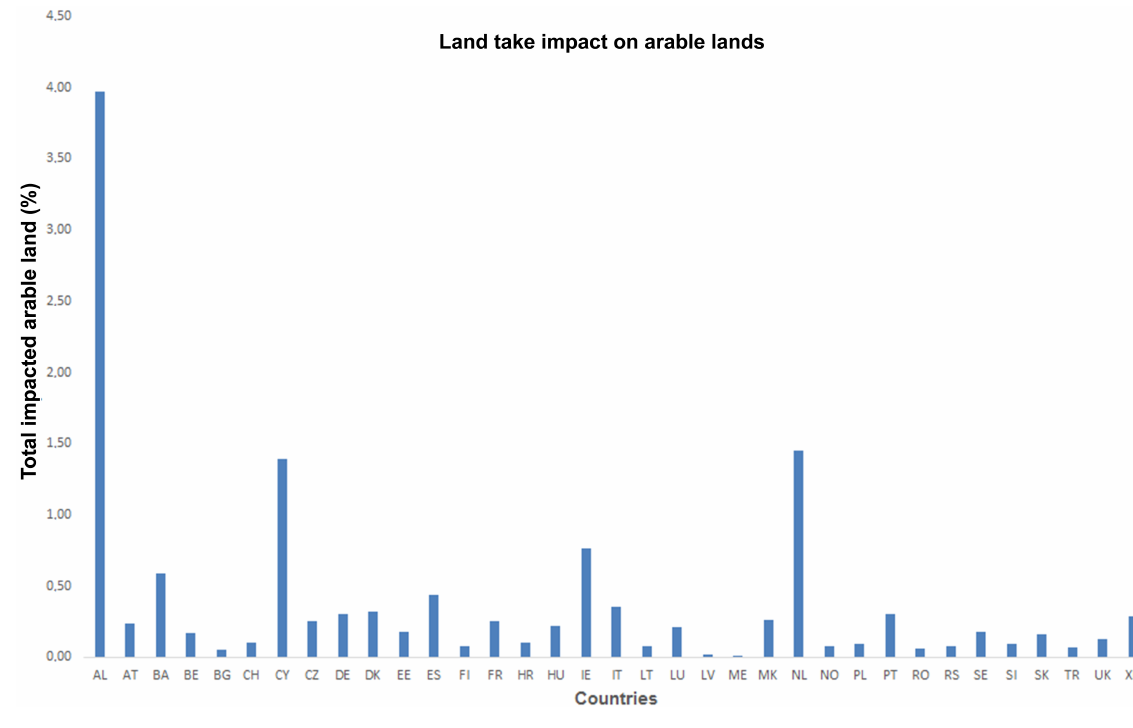
with poor, average, and good potentials for the provision of